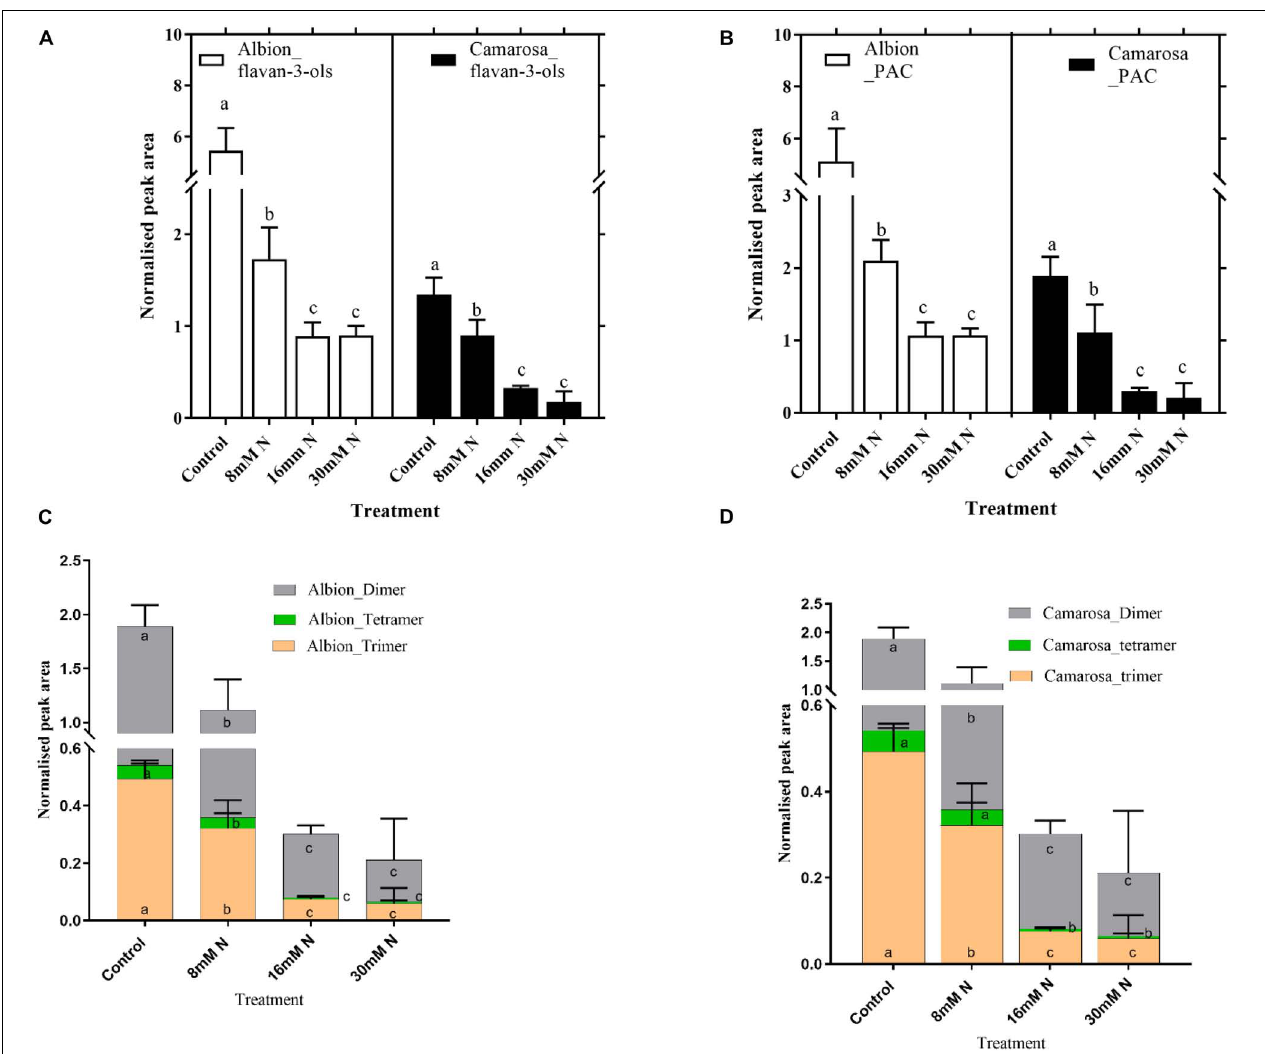
FIGURE 6 | Abundances of flavan-3-ols (A) and proanthocyanidins (B) and different subgroups of proanthocyanidins in Fragaria ananassa cv. Albion (C) , and cv. Camarosa (D) exposed to four N treatments. The data represent the mean ± SD ( n = 5) 13 C resveratrol (1 ng) normalized abundance and were tested by one-way ANOVA with Tukey’s honestly significant difference (HSD). Bars with the same letters are not significantly different at the 95% confidence